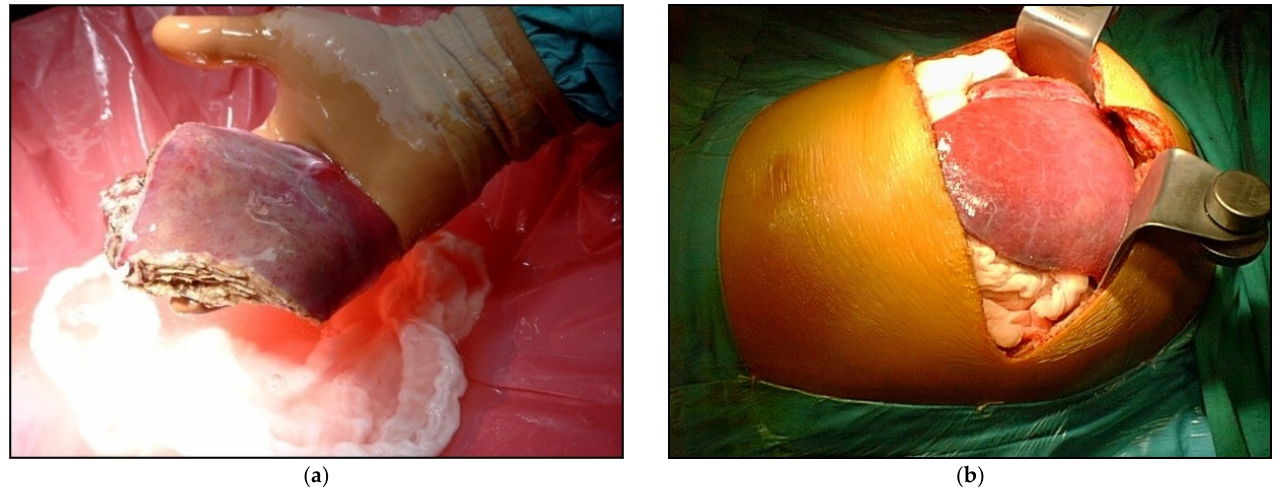
Figure 1. Example of LDLT with different types of graft ( a ) Reduced graft after backtable preparation; ( b ) During the recipient operations, the left lateral segments after reperfusion.